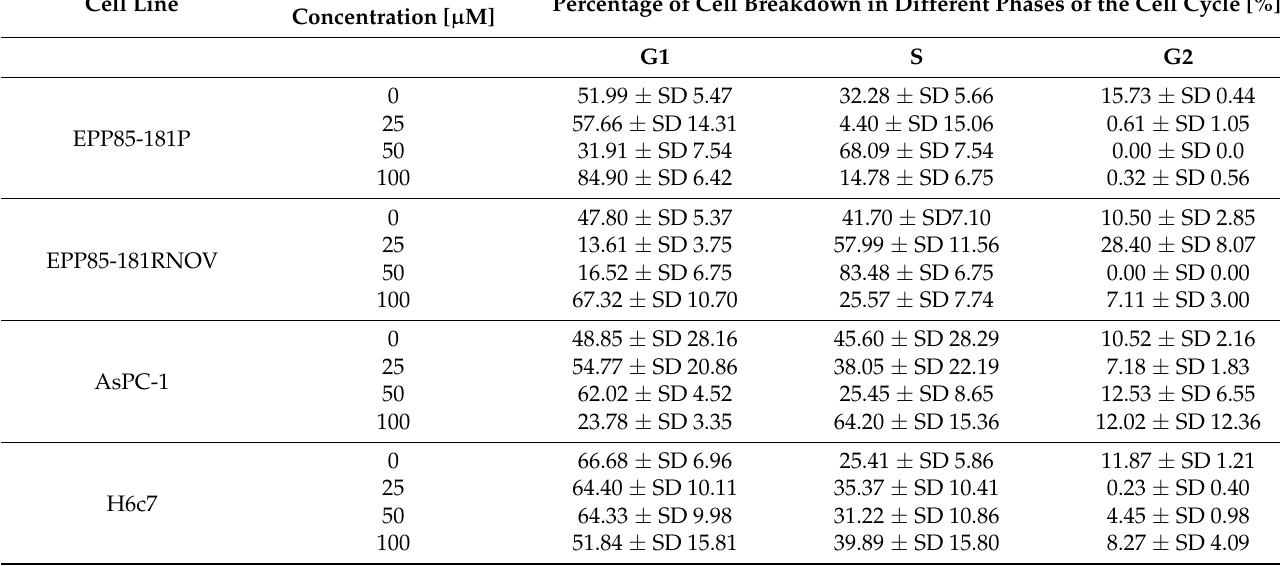
Figure 3. Cell distribution in particular phases of the cell cycle. ( A ) EPP85-181P cell line, ( B ) EPP85-181RNOV cell line, ( C ) AsPC-1 cell line, ( D ) H6c7 cell line, * p < 0.05; ** p < 0.01; *** p < 0.001. Table 1. Change in cell cycle phase distribution after 48-h treatment with resveratrol (0–100 µ M) on EPP85-181P, EPP85- 181RNOV, AsPC-1 and H6c7 cells. Results are presented as mean of triplicate measurements. Cell